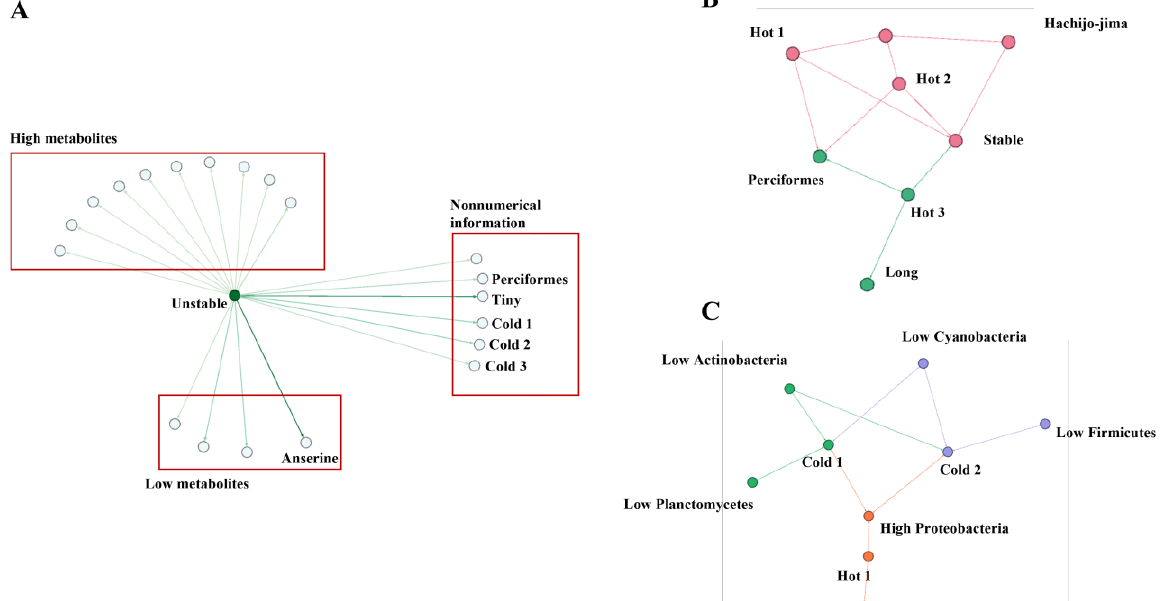
Figure 4. Network diagram of a priori association analysis of NMR and NGS data: ( A ) network of unstable state association factors; red boxes indicate categories; ( B ) network of stable state association factors; ( C ) network of NGS and temperature. Cold is defined as a water temperature below 20 ◦ C. Hot is defined as a water temperature over 25 ◦ C. The number after hot or cold is the number of months that have passed, including the current month. In other words, if the sample first experienced a water temperature of 25 ◦ C or more 2 months ago, it is written as Hot 3.